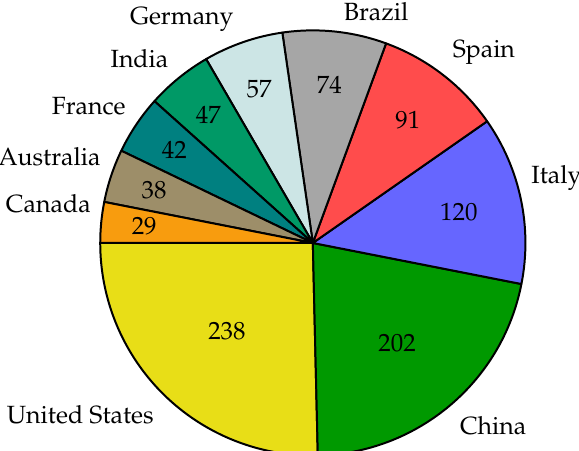
Figure 8. Published documents worldwide on adopting